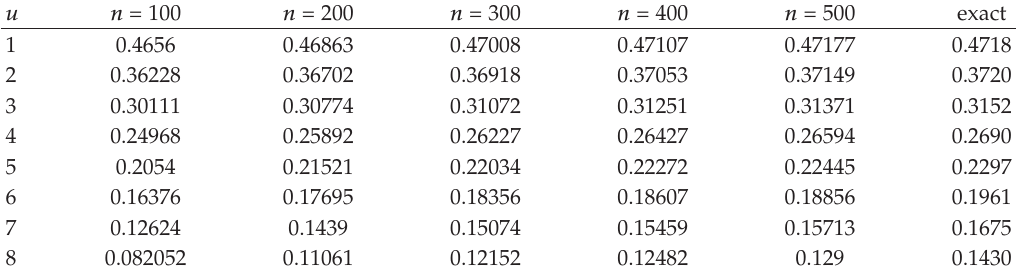
Figure 1: Laplace transform of the time to ruin. Table 1: Laplace transform of the time to